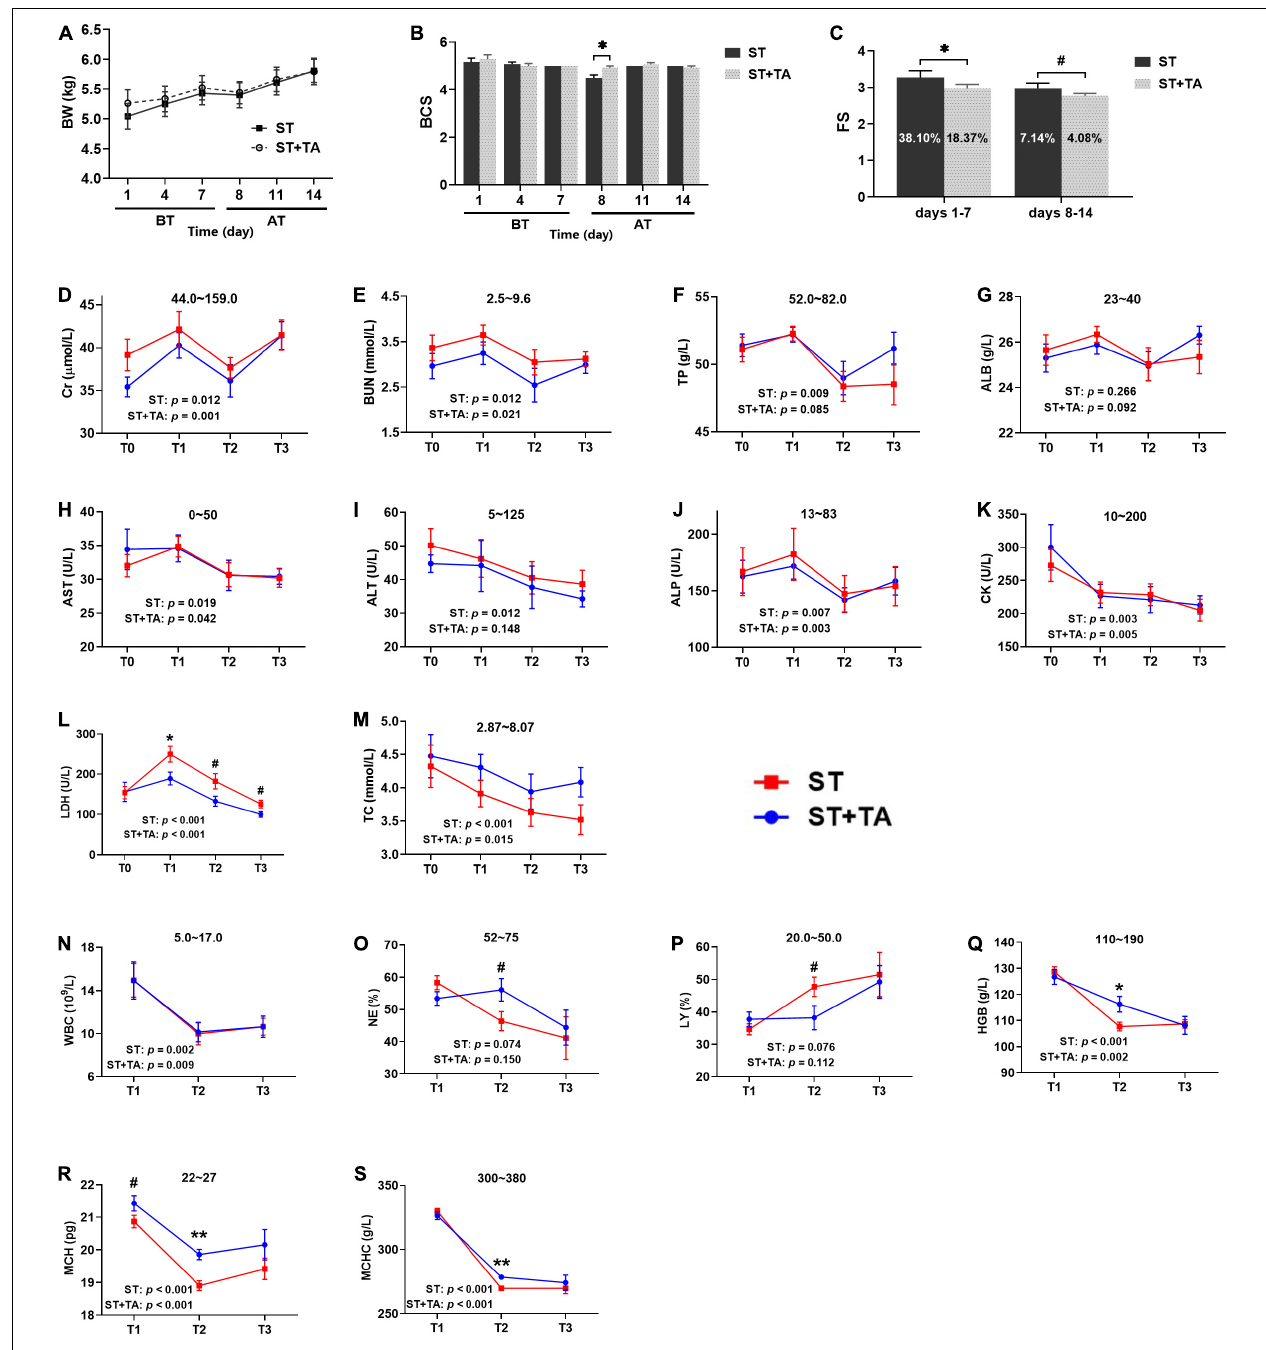
FIGURE 2 | Effect of TA on body condition (A,B) , fecal score (FS) (C) , serum biochemistry (D–M) , and hematology (N–S) in dogs. Data are presented as mean ± standard error (SE) ( n = 6 or 7). * p < 0.05 and ∗∗ p < 0.01 represent the difference calculated by Student’s t -test between the stress (ST) and ST + TA groups; # p < 0.10 represents the difference in tendency calculated by Student’s t -test between the ST and ST + TA groups. The p -values in the figures indicate the difference of each group at T1–T3 calculated by repeated-measure analysis of variance (RM-ANOVA). Numbers in the column chart indicate the diarrhea rate. Numbers at the top of each figure refer to the normal reference ranges for serum biochemistry and hematology indices. BT, before transportation; AT, after transportation; T0, day 1 before transportation; T1, day 7 before transportation; T2, day 8 after transportation; T3, day 14 after transportation. Cr, creatinine; BUN, blood urea nitrogen; TP, total protein; ALB, albumin; AST, aspartate aminotransferase; ALT, alanine aminotransferase; ALP, alkaline phosphatase; CK, creatine kinase; LDH, lactate dehydrogenase; TC, total cholesterol; WBC, white blood cell count; NE, neutrophils; LY, lymphocyte; HGB, hemoglobin; MCH, mean corpuscular hemoglobin; MCHC, mean corpuscular hemoglobin